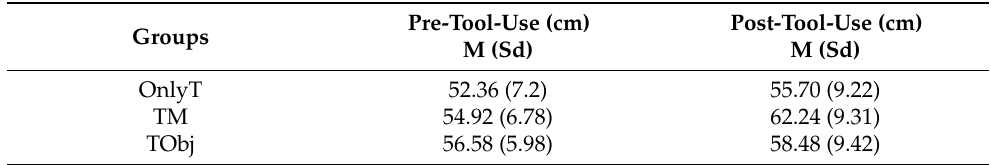
Table 1. Mean and SD Reaching Distances (cm) of the Pre-tool-use and Post-tool-use conditions for each group.